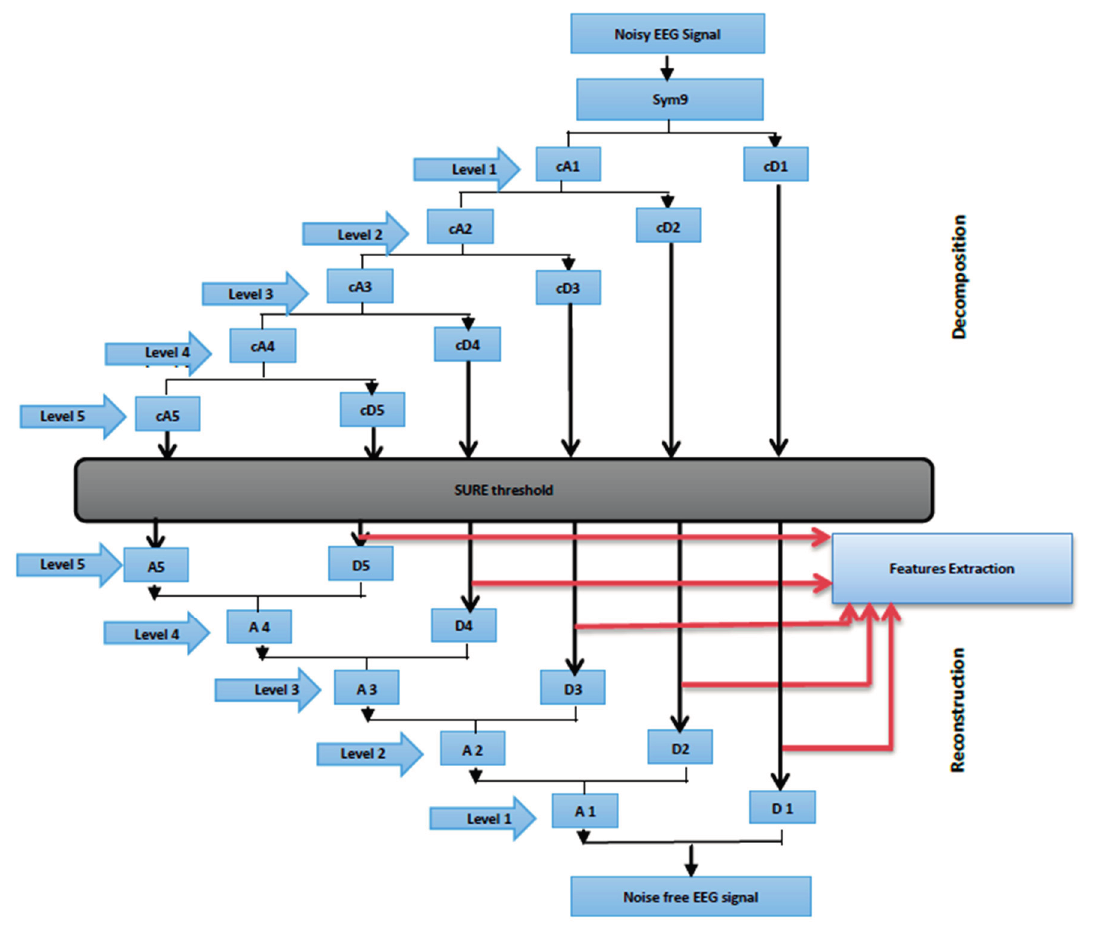
Figure 6. Wavelet Multi-resolution